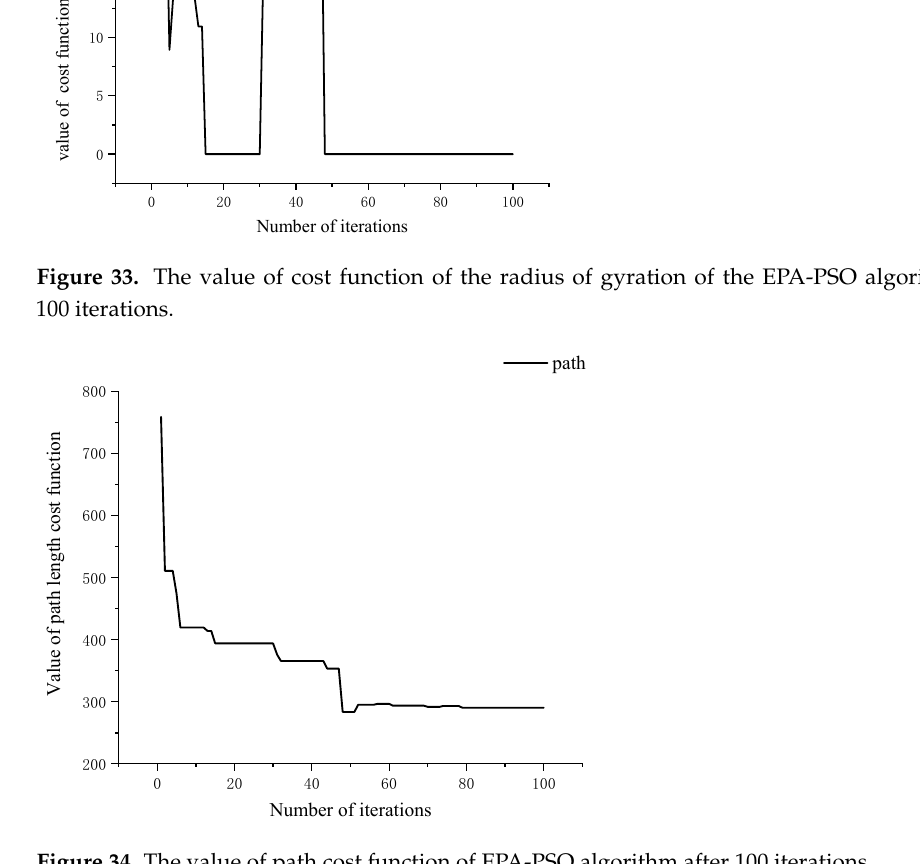
Figure 34. The value of path cost function of EPA-PSO algorithm after 100 iterations.